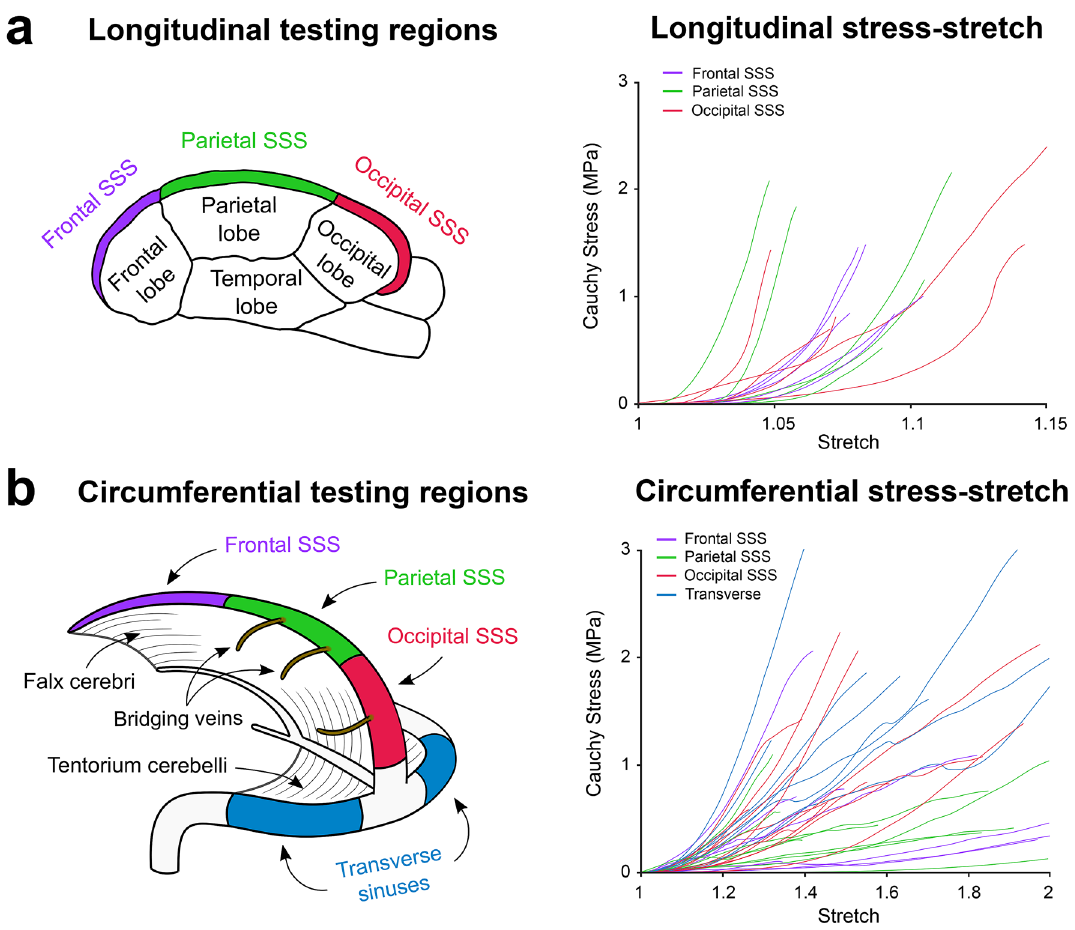
Figure 1. Illustration of the regions tested with the accompanying plots of the Cauchy stress-stretch curves of the dural venous sinus samples tested in ( a ) the vessel’s longitudinal test direction and ( b ) the vessel’s circumferential test direction. Note the different scales on the x-axes of the stress-stretch